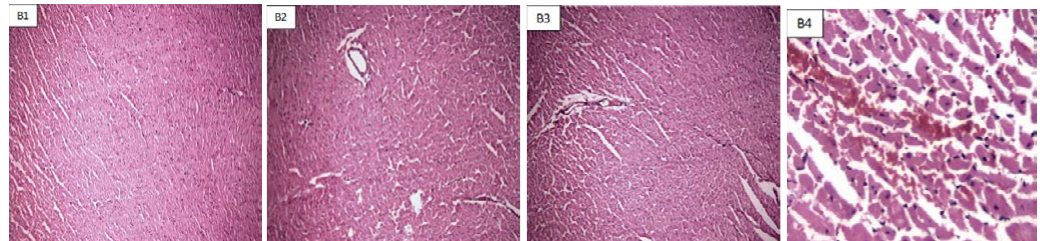
Fig. 3. Photomicrographs of heart sections obtained from rats exposed to different concentrations of IONs. (B2, B3, B4) control rats received 50, 500, 5000 mg/kg of IONs, respectively (B1, B2, B3): normal heart, B4: Hemorrhage in heart, (Staining with hematoxylin and eosin). Magnification: 40 x for panels.